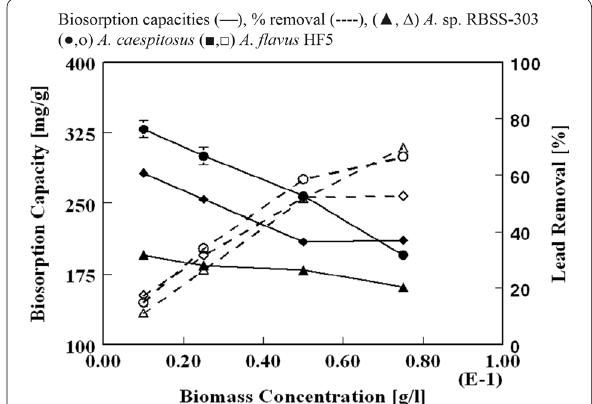
Fig. 2 Pb(II) uptake capacities and % removal by A. sp. RBSS-303, A. caespitosus and A. flavus HF5 as a function of biomass concentration